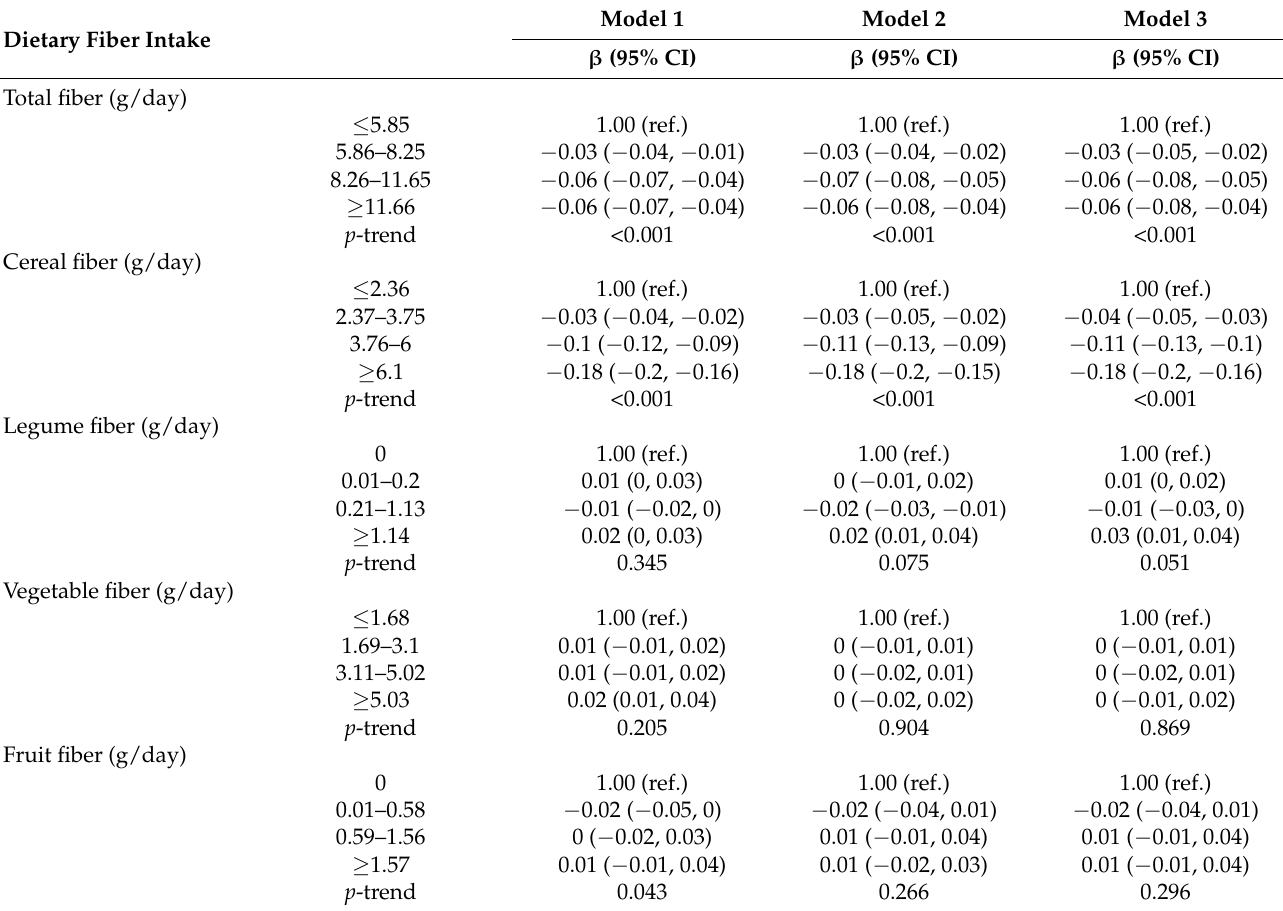
Table 3. Multivariable linear associations between dietary fiber intake and serum uric acid ( n = 66,427).